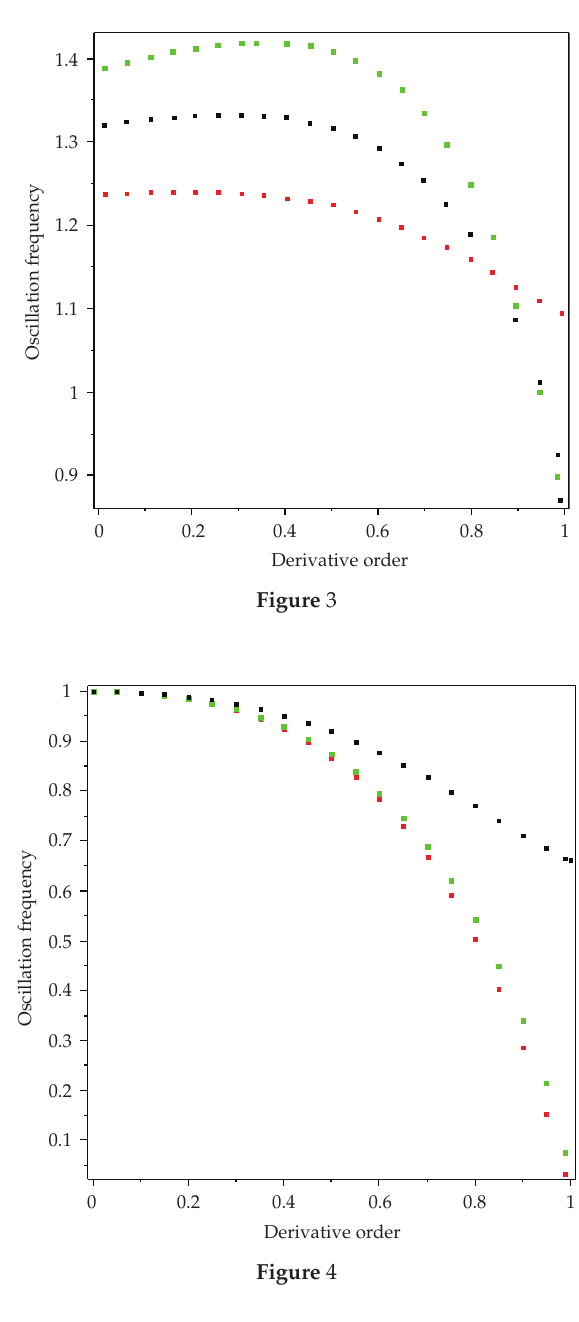
Figure 3 is a representative graph of case one, λ (cid:8) ω 2 > 1. The green graph is for λ (cid:4) ω (cid:4) 1, the black graph is for λ (cid:4) 2 and ω (cid:4) 1, and the red graph is for λ (cid:4) 3 and ω (cid:4) 1. Figure 4 is a representative graph from case two, λ (cid:8) ω 2 (cid:4) 1, a flat start. The red graph √ 2 − 1 (cid:5) and ω (cid:4) λ/ 2, the green graph is for λ (cid:4) 1 / 2 and ω (cid:4) 1 / is for λ (cid:4) 2 (cid:3) graph is for λ (cid:4) 15 / 16 and ω (cid:4) 1 /